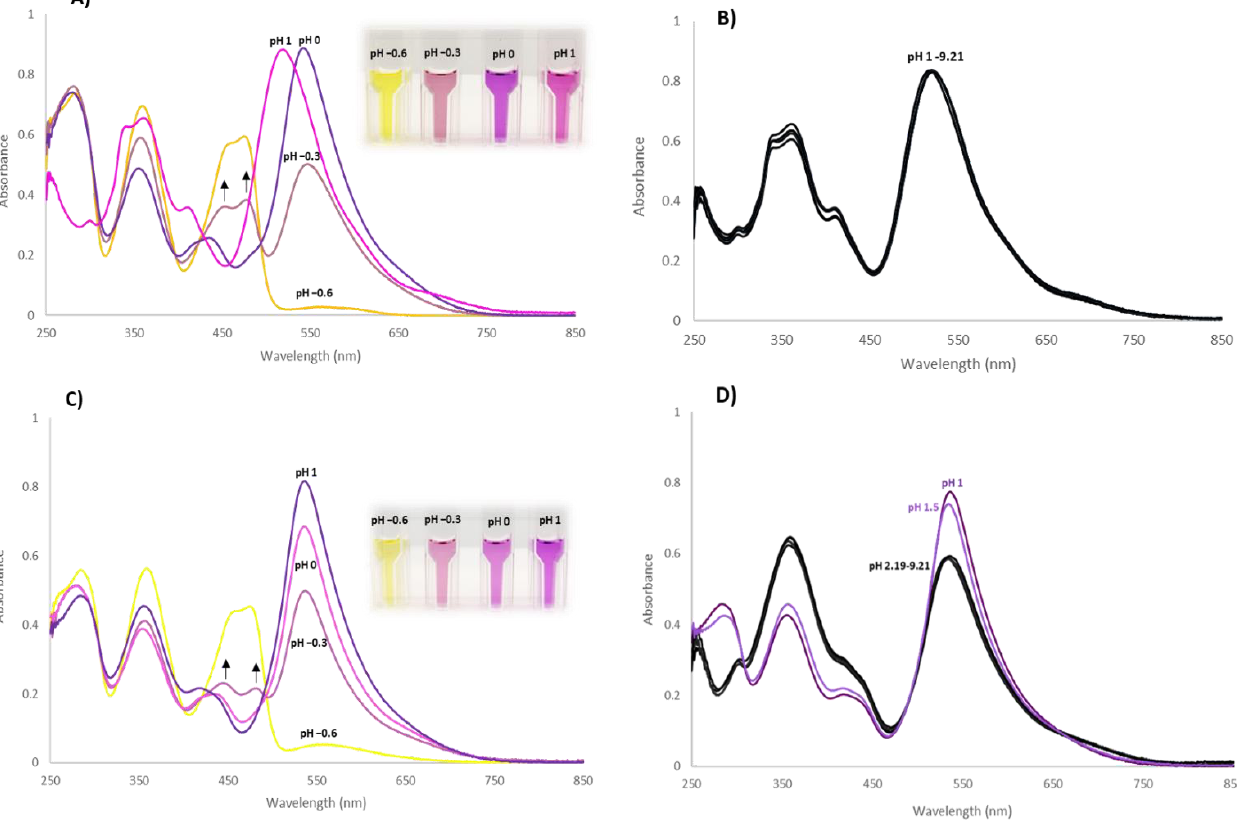
Figure 4. UV-Visible spectra of 4-dimethylamino cinnamate pyranoflavylium ester in aqueous solution at ( A ) pH −0.6, −0.3, 0 , and 1, and ( B ) pH range of 1 – 9.21, and 4-amino cinnamate pyranoflavylium ester in aqueous solutions at ( C ) pH −0.6, −0.3, 0 , and 1 and ( D ) pH range of 1 – 9.21.